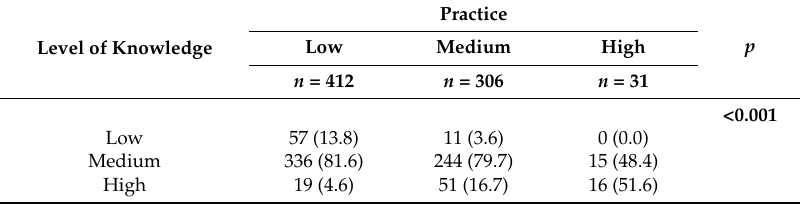
Table 5. Relationship between participant’s level of knowledge and practice when considering sex and status.